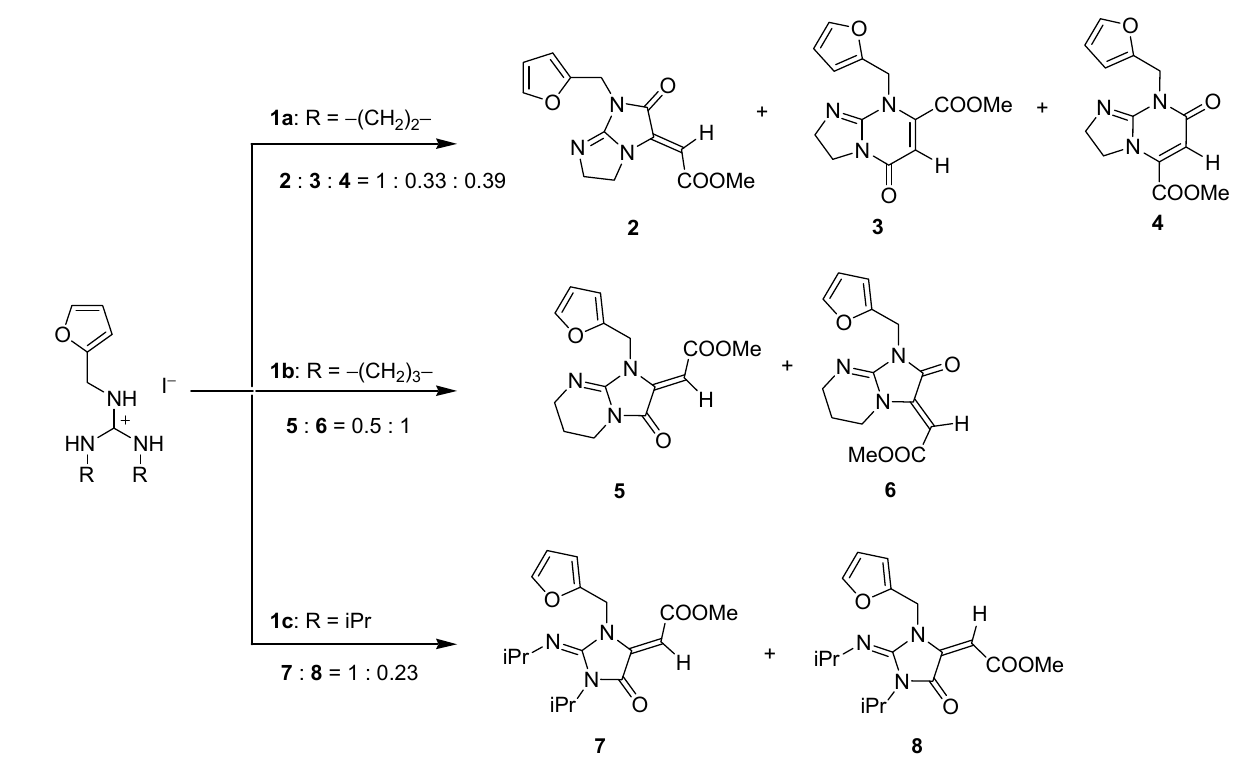
Figure 1. Structures of various products obtained by AMA/CYC tandem reaction of guanidinium salts 1a – 1c with DMAD [23]. Relative ratios are calculated from the 1 H NMR spectra of the reaction mixtures.